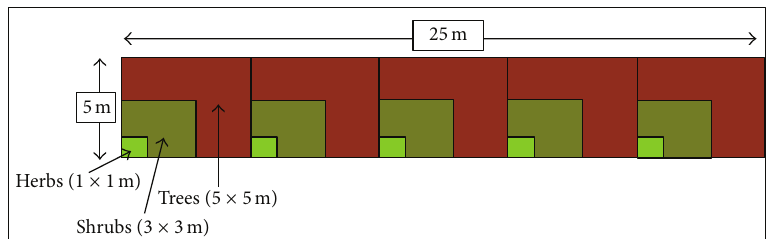
Figure 2: Sampling plot in which abundance and height class of herbs, shrubs, and trees species were measured.